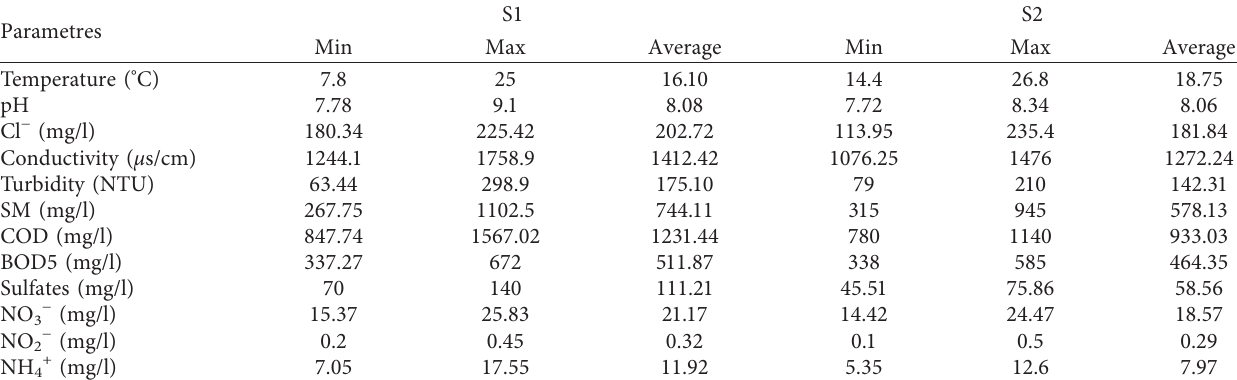
Table 3: Physicochemical parameters study sites